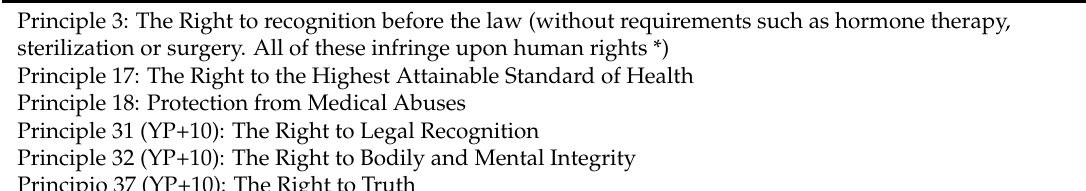
Table 2. Yogyakarta Principles. Extract.